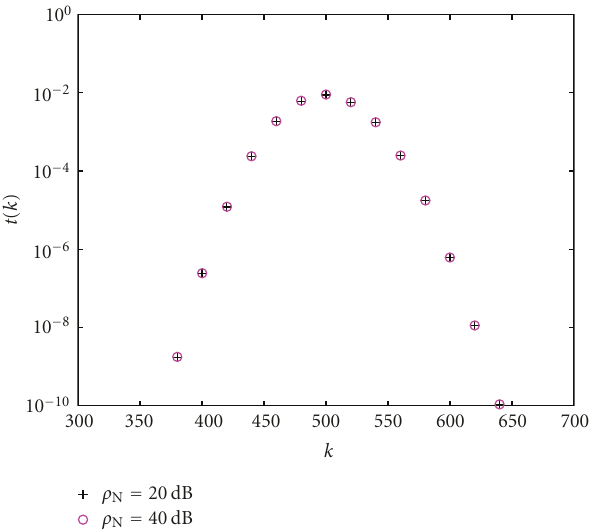
Figure 2: Evaluation of t ( k ) in (12) when ρ I = 30 dB.